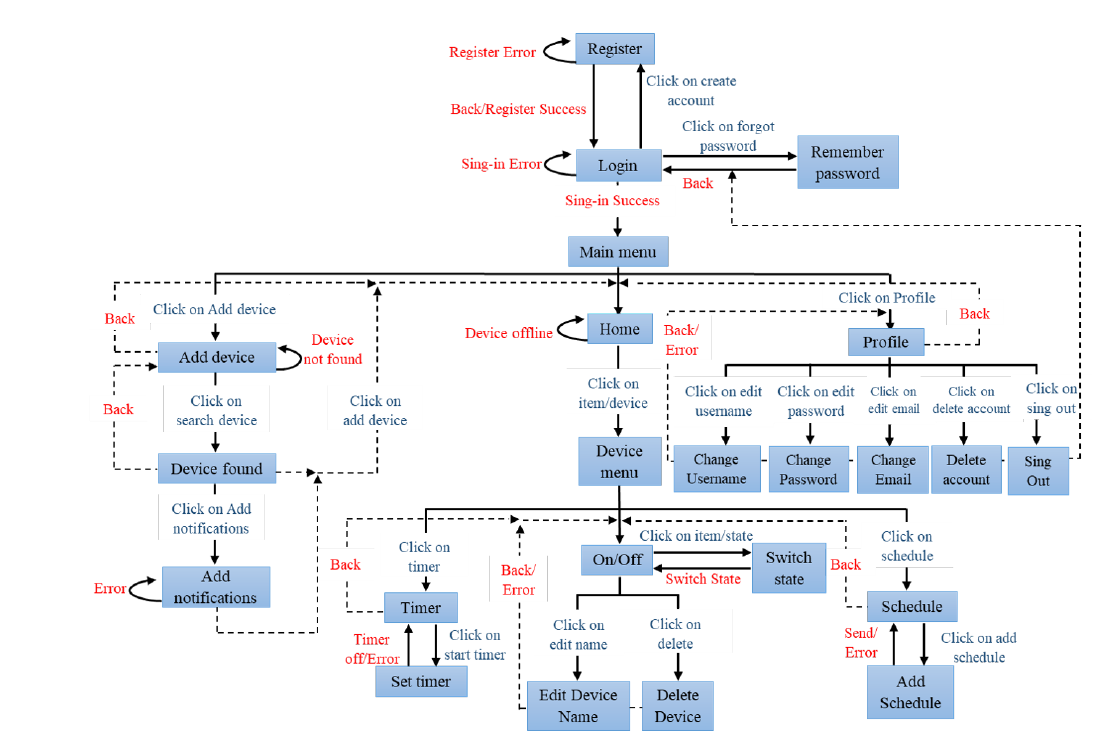
Figure 4. Mobile app window